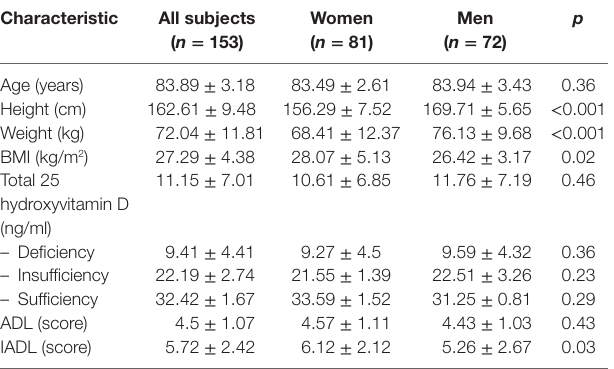
Table 1 | Basic descriptive characteristics of study population (mean ± SD).